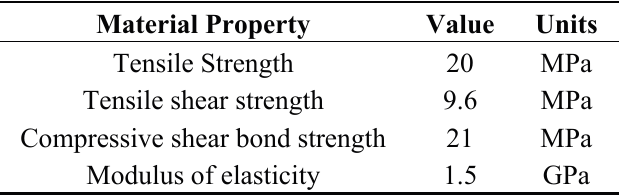
Figure 16. Stress-strain curves of CFRP, AFRP, GFRP and PP-band. Table 1. Material properties of